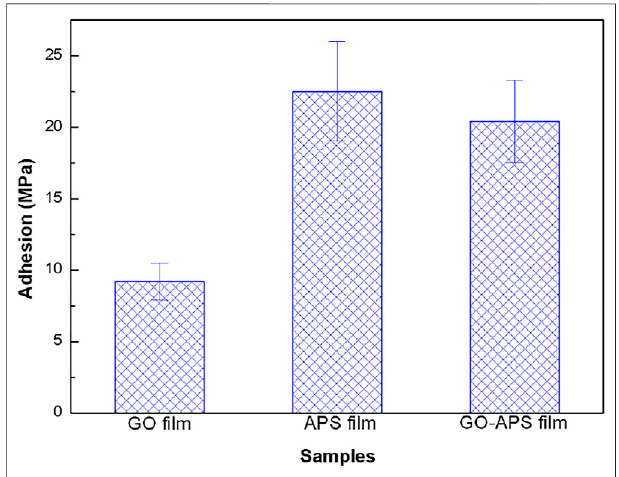
FIGURE5| Ramanspectraof fi lm-coatedMgalloysamples: (A) GO fi lm; (B) APS fi lm; (C) GO-APS fi lm.